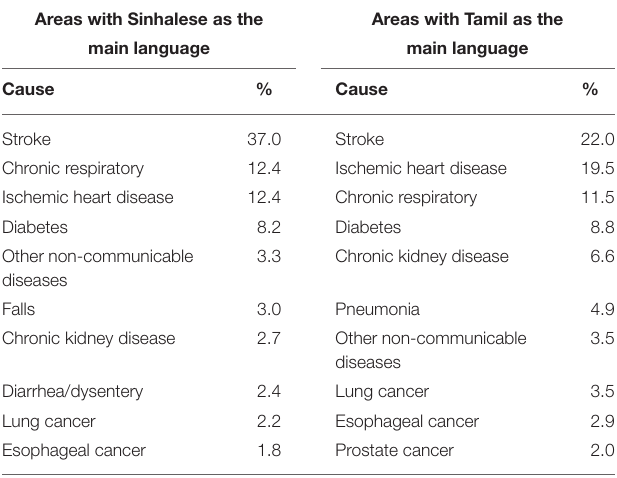
TABLE 3 | Leading causes of death (CSMFs), adults, Sri Lanka, according to main-language regions. Areas with Sinhalese as the Areas with Tamil as